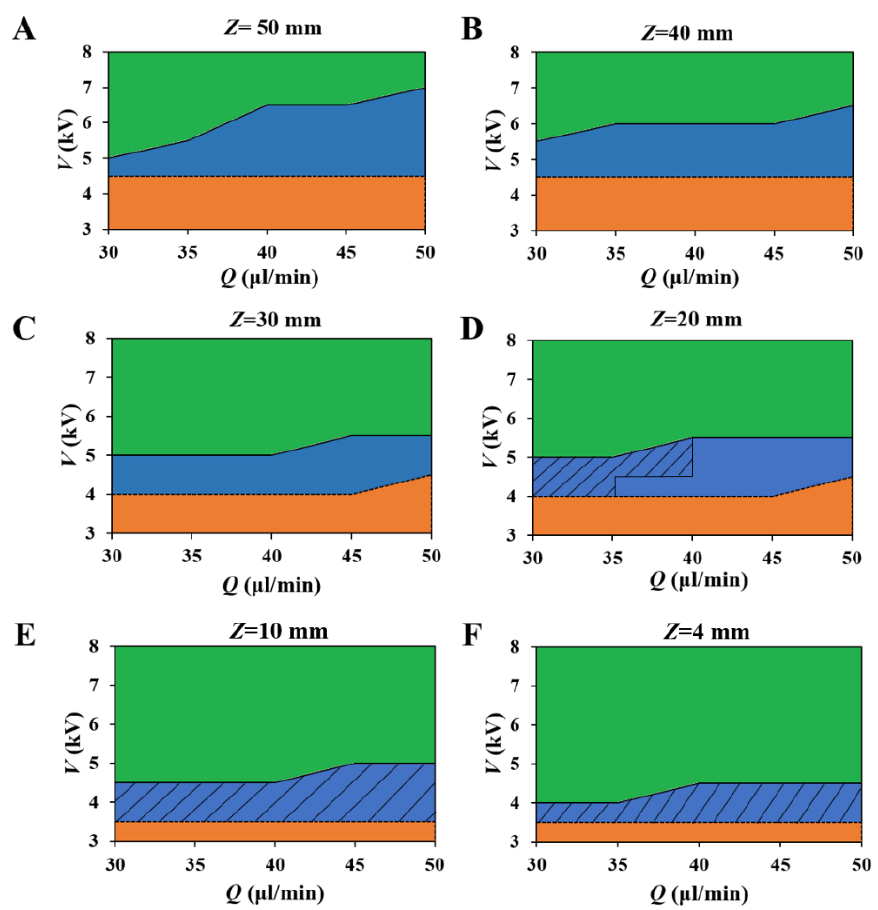
Figure 3. The domains of multi-jet mode (green), single-jet mode (blue), and dripping mode (orange) in the V–Q parameter plane at different nozzle–collector distance: ( A ) Z = 50 mm, ( B ) Z = 40 mm, ( C ) Z = 30 mm, ( D ) Z = 20 mm, ( E ) Z = 10 mm, ( F ) Z = 4 mm. (The dash areas are EHD direct-writing domains.).